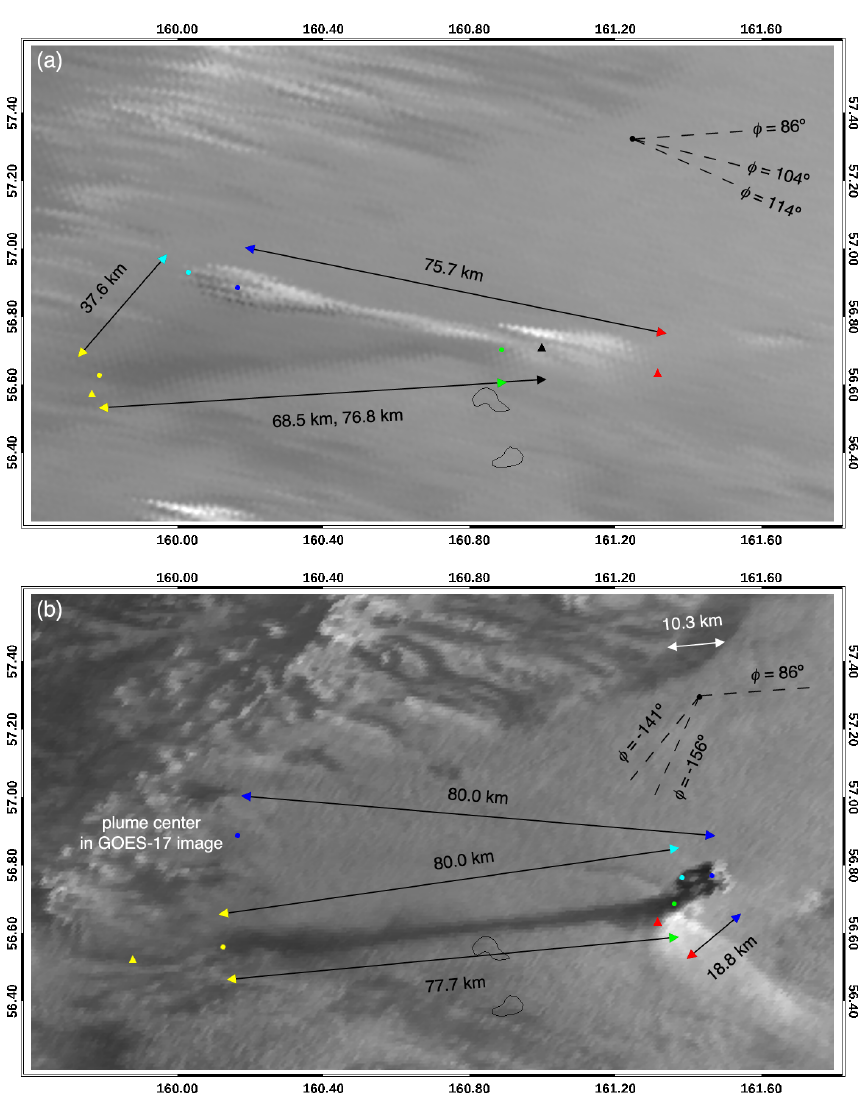
Figure 4. Equirectangular map projection of the 19:10UTC (a) GOES-17 band 2 and (b) Himawari-8 band 3 image of the 8 April 2020 eruption of Sheveluch. The red and black triangles mark the volcano base and the vent, respectively. The green dot indicates the start point of the visible shadow, which for the Himawari-8 image is nearly the same as the vent location (thus, the black triangle is not shown in panel b ), while the yellow dot is the shadow terminus on the cloud layer. The yellow triangle is the estimated position of the shadow terminus had it been cast directly on the surface without the intervening cloud layer. The blue and cyan dots respectively correspond to the center and the westernmost edge of the umbrella cloud; the GOES-17 image location of the plume center is shown in the Himawari-8 image too. Double-headed arrows indicate the ellipsoid-projected distance and direction between the points matching the color of the arrowheads. The white arrow marks the shadow of the low-level cloud layer on which the eruption column casts its shadow. The true and map distorted view azimuths at the volcano base ( φ = 114 ◦ and φ = 104 ◦ for GOES-17, and φ = − 156 ◦ and φ = − 141 ◦ for Himawari-8) as well as the mapped solar azimuth ( φ = 86 ◦ , little distortion) are also